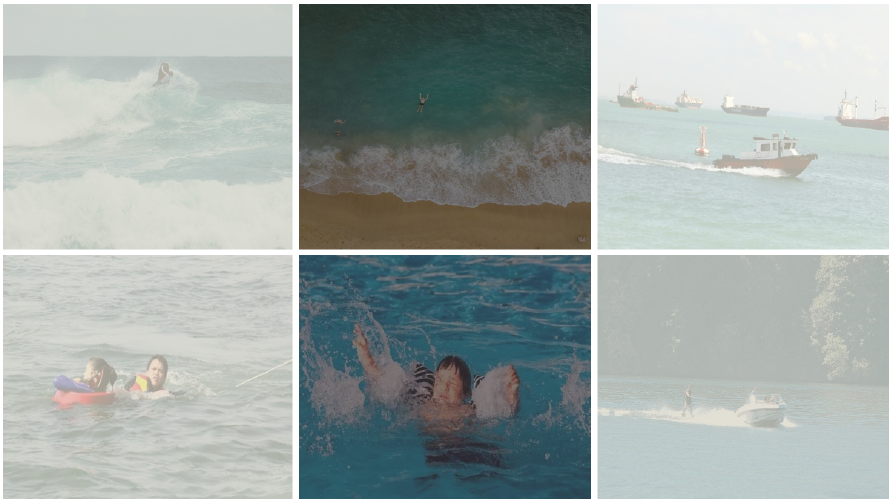
Figure 5. The partial dataset in foggy